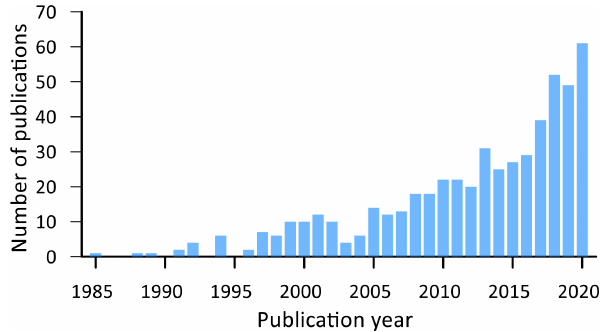
Figure 5. Number of publications found in the “Web of Science” using the search query “HBV AND (runoff OR hydrology)” (per- formed on 2 October